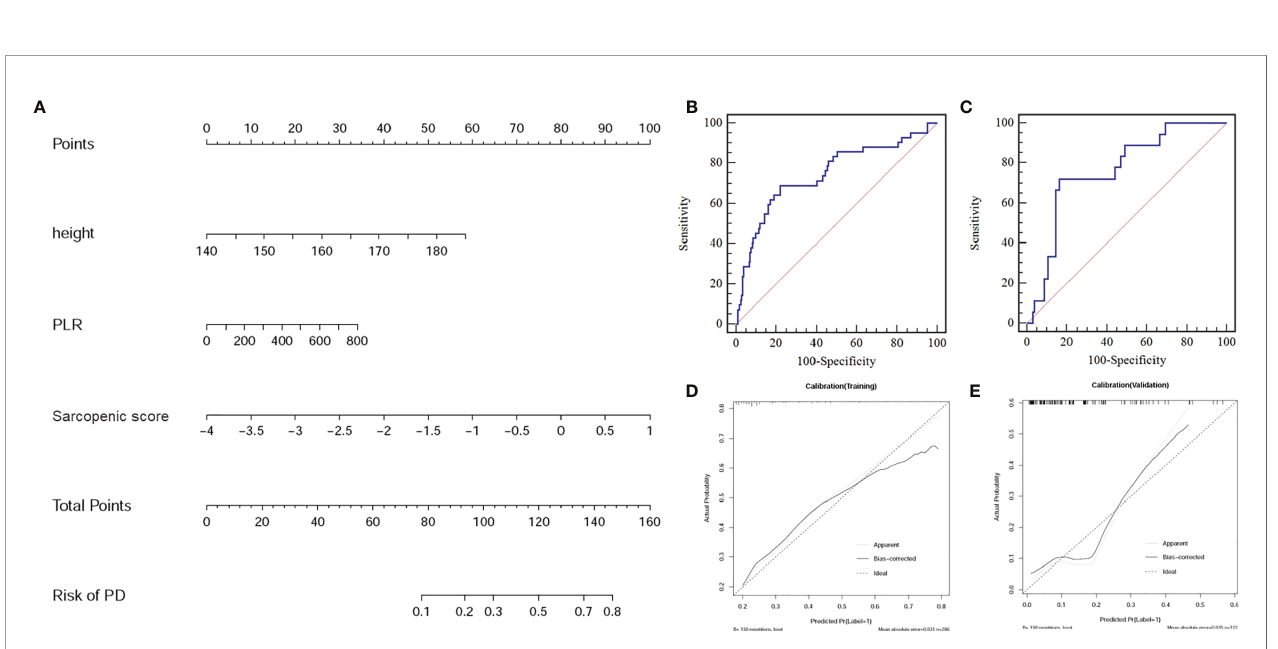
FIGURE 3 | Forest plot demonstrating the independent predictors for progressive disease (PD) for patients with advanced non-small-cell lung cancer (NSCLC). PLR, Platelet-to-Lymphocyte ratio.